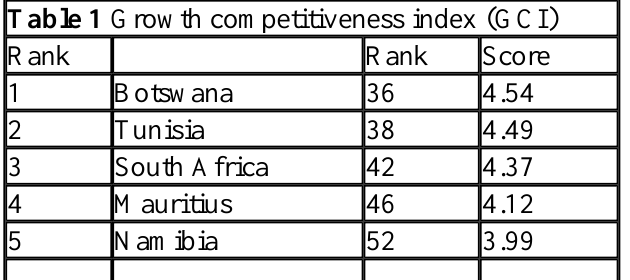
Table 1 Growth competitiveness index